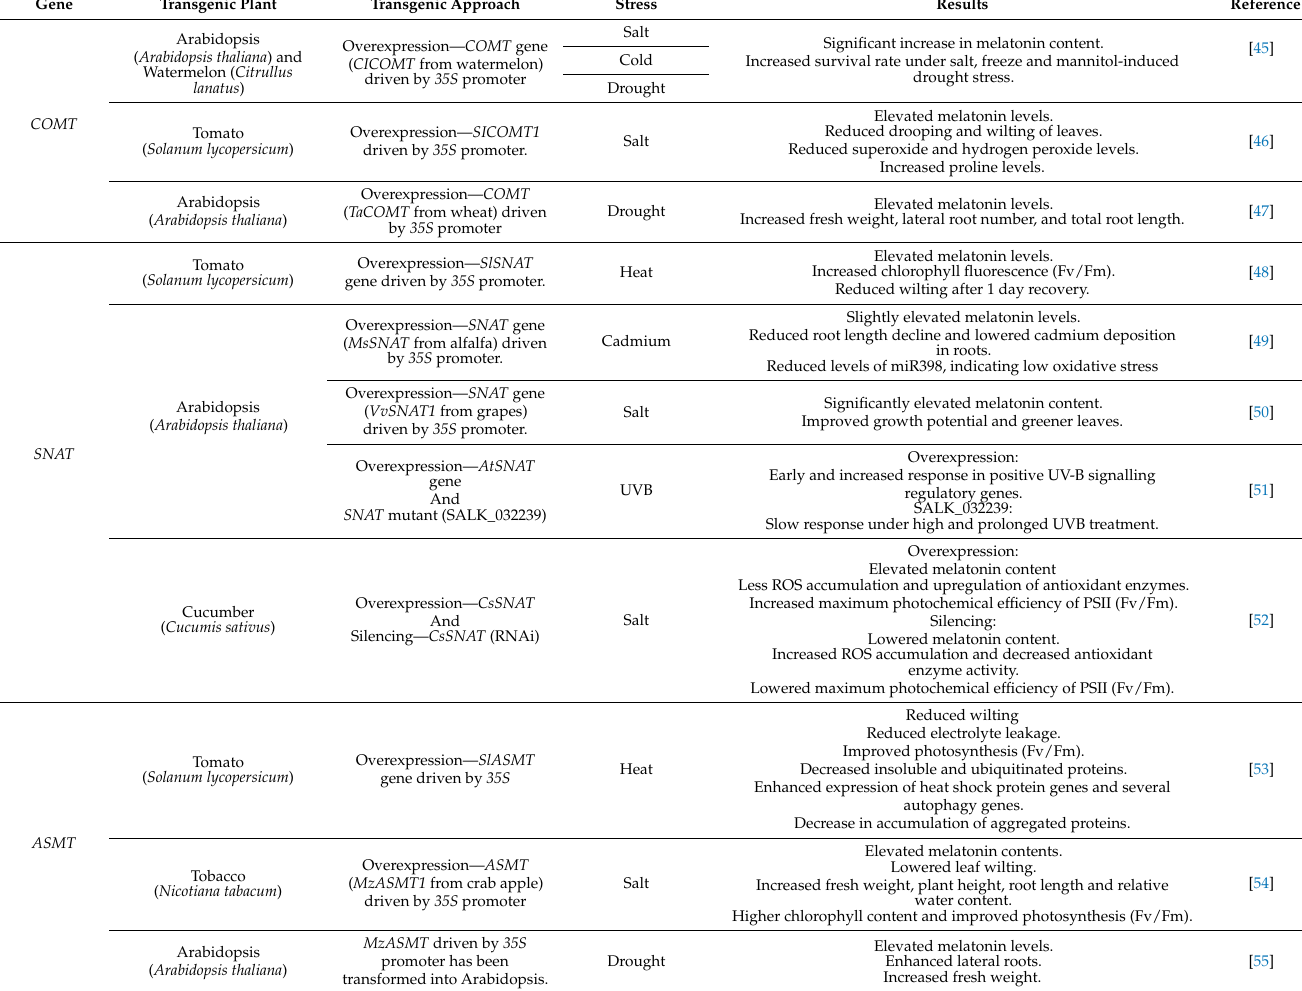
Table 1. A summary of the transgenic approaches to modulate the phytomelatonin biosynthesis